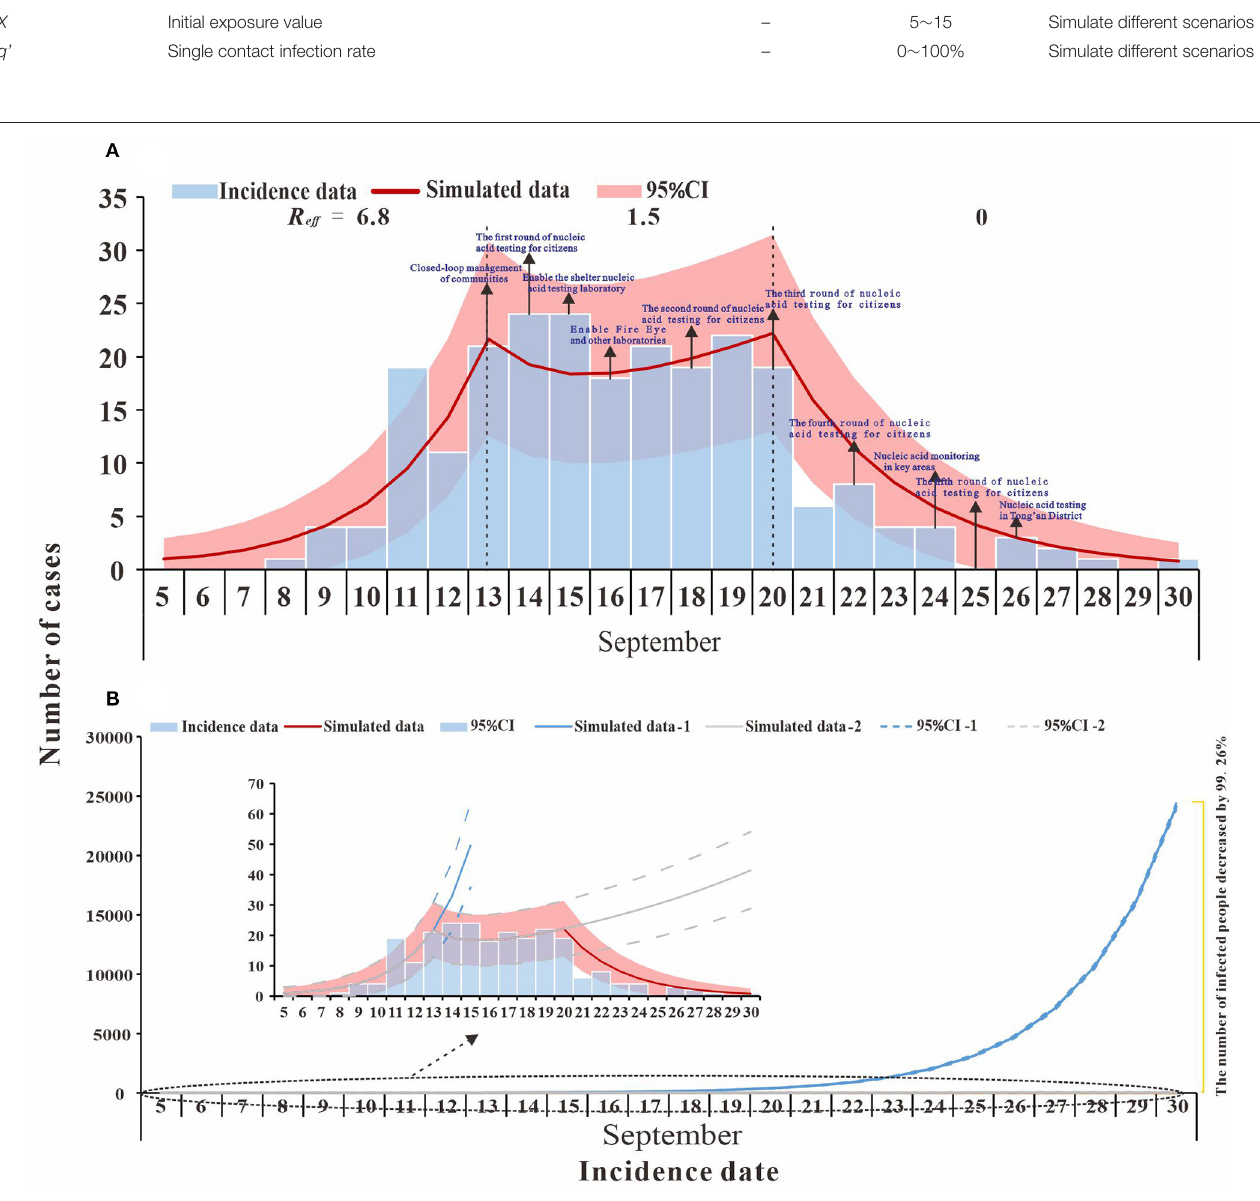
FIGURE 2 | Fitting results of the SEIR model and the data of the actual secondary cases of SARS-CoV-2 infections in Xiamen City, China, 2021. (A) evaluation of COVID-19 transmissibility (Reff = 6.8, 1.5, and 0); (B) effect of intervention measures at different stages.